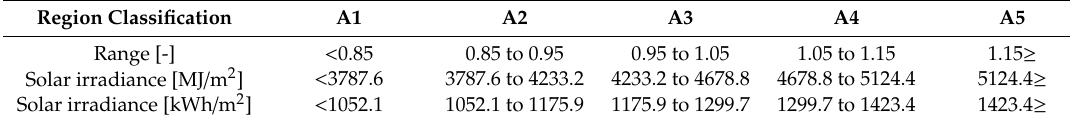
Table 11. Japanese solar global horizontal irradiance classification of each region.